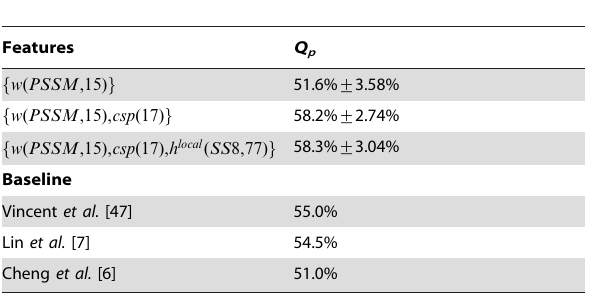
Table 5. Evaluation of the proposed prediction pipeline.